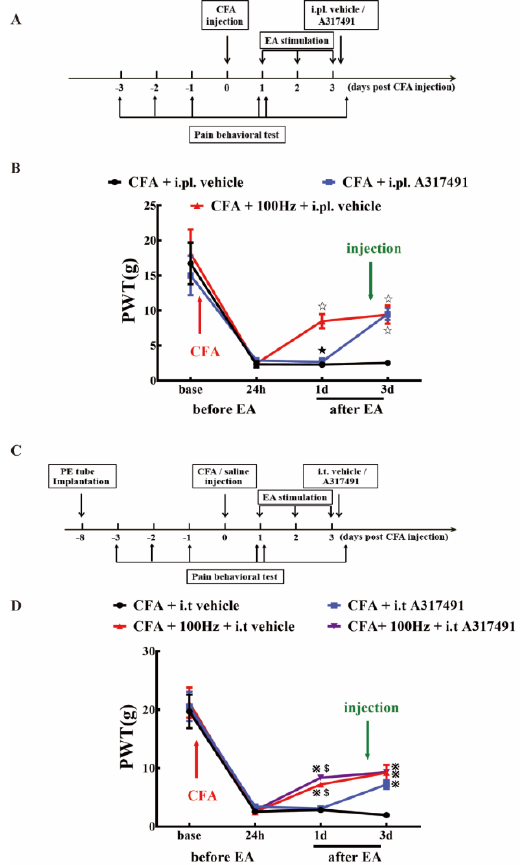
Figure 8. P2X3 inhibition contributed to the analgesic effects of 100 Hz EA on CFA-induced inflammatory pain. (A) Schematic flow diagram of the intraplantar injection of P2X3 antagonist A317491. ( B )The effect of intraplantar injection of A317491 on the PWT. Data are presented as the